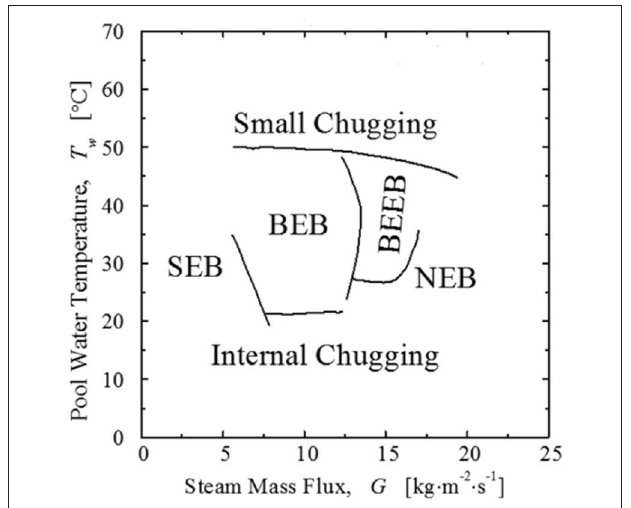
FIGURE 10 | The regime maps developed by Gregu et al. (2017).